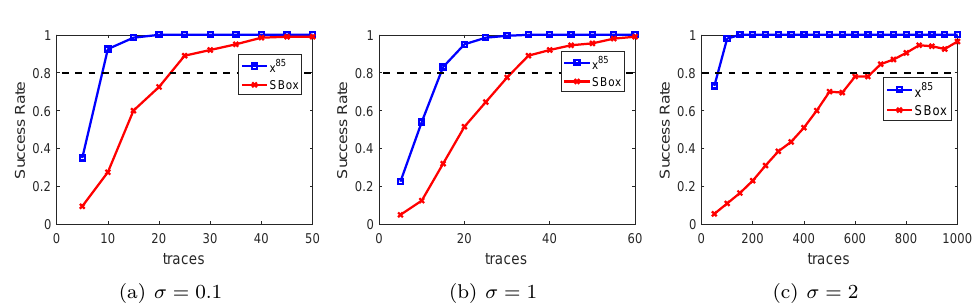
Figure 14: The success rate of deep learning based profiling attacks on simulated leakages with different noise levels.